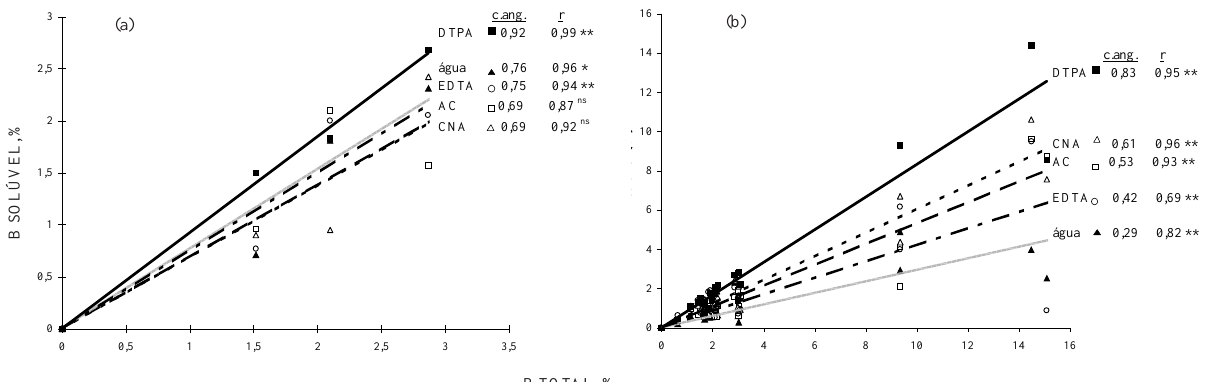
Figura 5. Solubilidade do boro presente em fertilizantes comerciais solúveis (a) e insolúveis em água (b), nos diversos extratores utilizados, e respectivos coeficientes angulares das retas (c.ang.) e coeficientes de correlação (r). ** e ns significativo a 5% e não-significativo,